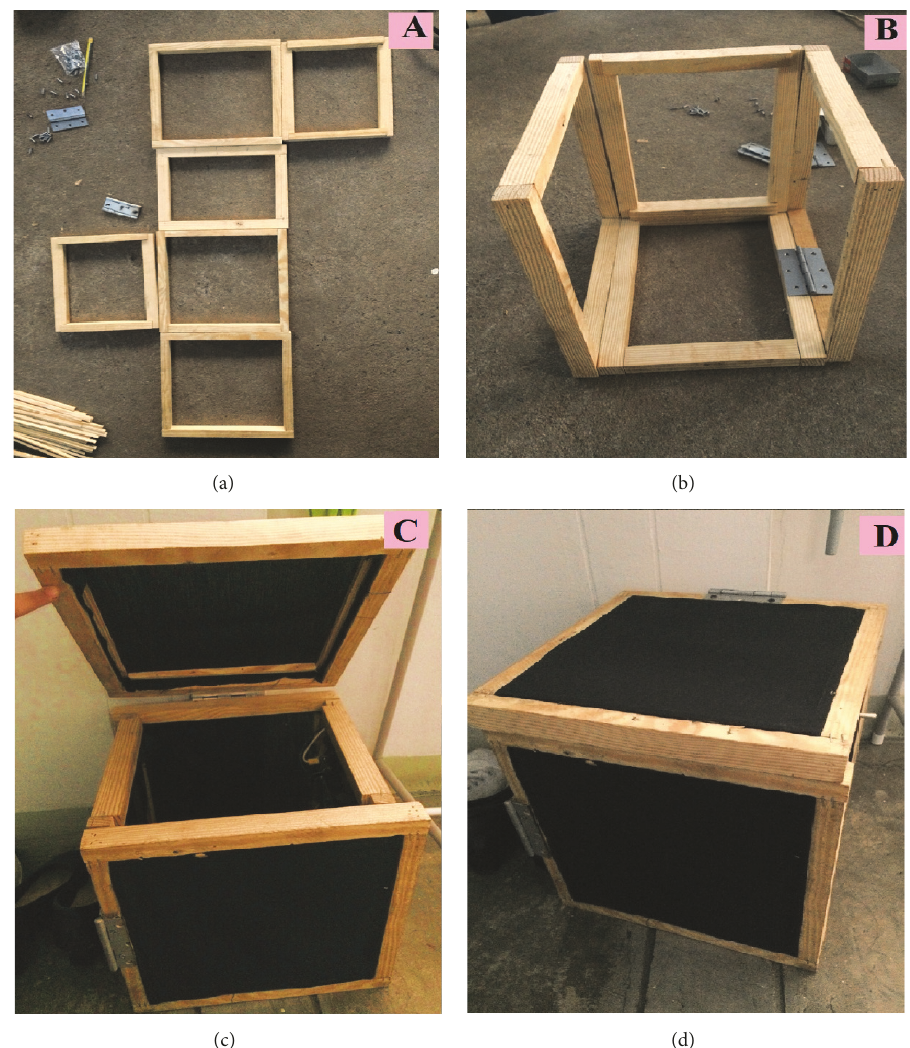
Figure 2: Design of the mosquito trapping box tested in Step 2 of the research and development phase. (a) A wooden frame was constructed using tacks; (b) the wooden frame was then used to make a square box with an opening lid for mosquito removal; (c) black cotton cloth was attached to the wooden frame; (d) appearance of the final wooden trapping box combined with black cotton